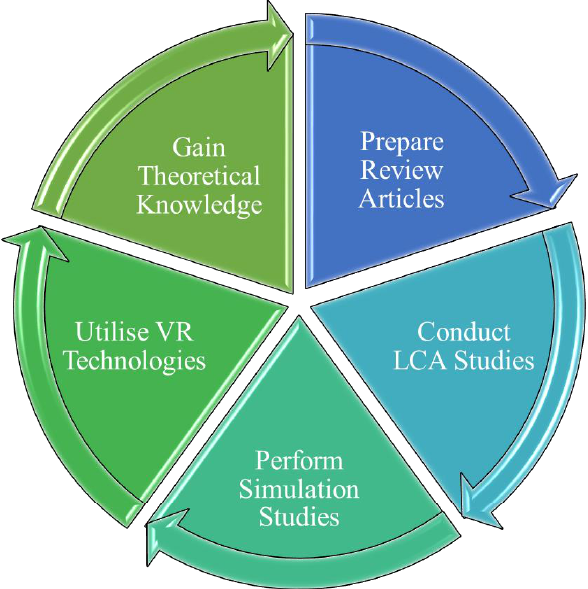
Figure 1. The five strategies for students and researchers to adopt in order to maintain the continuity of biocomposites education during a pandemic.